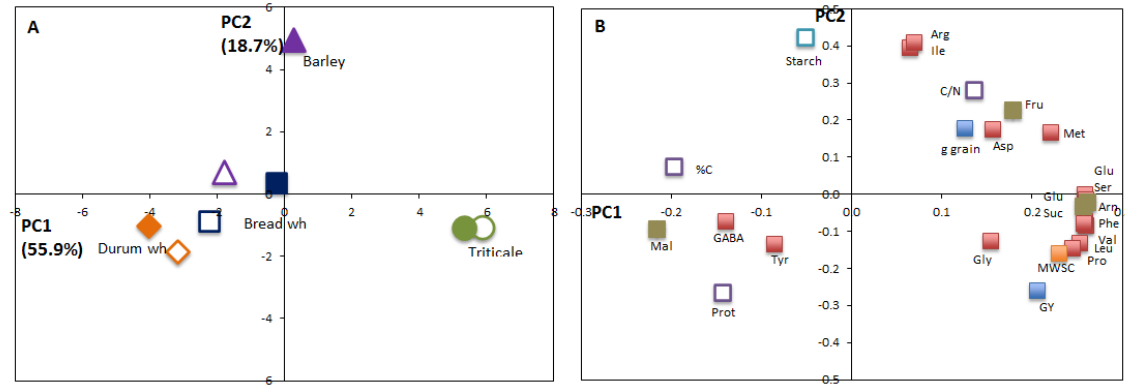
Figure 9. Biplot of the first two components (PC1 and PC2), for the principal component analysis (PCA) of 29 traits evaluated in the four cereals triticale (circles), bread wheat (squares), durum wheat (diamonds) and barley (triangles). PC1 and PC2 explained 55.9% and 18.7% of the variability, respectively. Measurements were performed at maturity. Data used for the PCA are mean values of all traits evaluated in each genotype and water availability regime. In the score plot ( A ), closed and open circles represent the well-watered and water-limited regimes, respectively. In the loading plot ( B ) is the distribution of AAs.